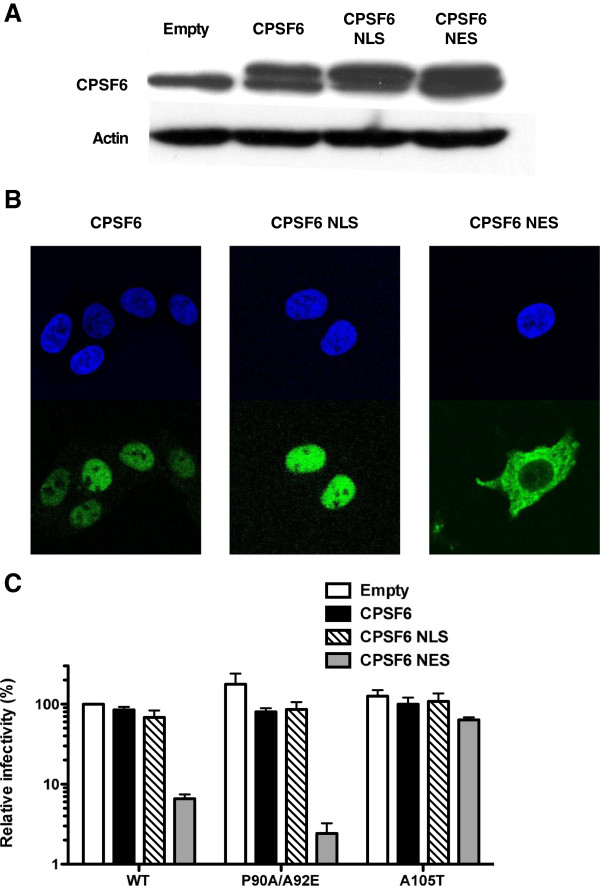
HIV-1 replication is inhibited when full-length CPSF6 is targeted to the cytoplasm. (A) Expression levels of CPSF6 in TZM-bl cells transduced with empty, CPSF6, CPSF6-NLS and CPSF6-NES vectors. Cell lysates were probed in western blots with anti-CPSF6 antibody (upper panel) and anti-β-actin antibody (lower panel). The upper panel shows the endogenous and exogenous full-length CPSF6 with an HA tag. (B) Localization of different forms of CPSF6 in TZM-bl cells stably expressing CPSF6, CPSF6 NLS or CPSF6 NES. The cells were stained with an anti-HA antibody (green) for the detection of the CPSF6 proteins. DAPI staining (blue) was used to mark the nuclear compartment. (C) TZM-bl stably expressing the different forms of CPSF6 were challenged with WT or CA mutant HIV-1NL4-3GFP reporter viruses. After 72 hours, GFP reporter expression was assessed by flow cytometry. Data represent one of at least three independent experiments. Error bars represent ± SEM (n = 3).